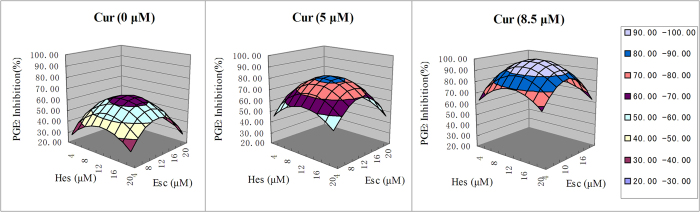
Response surface analysis and effect prediction of PGE2 inhibition by different combinations of principal constituents from BE-IS.The response surface figure was drawn with a fixed Cur, where Esc and Hes were used as the X and Y axis, respectively, and PGE2 release inhibition rate was used in the Z axis.